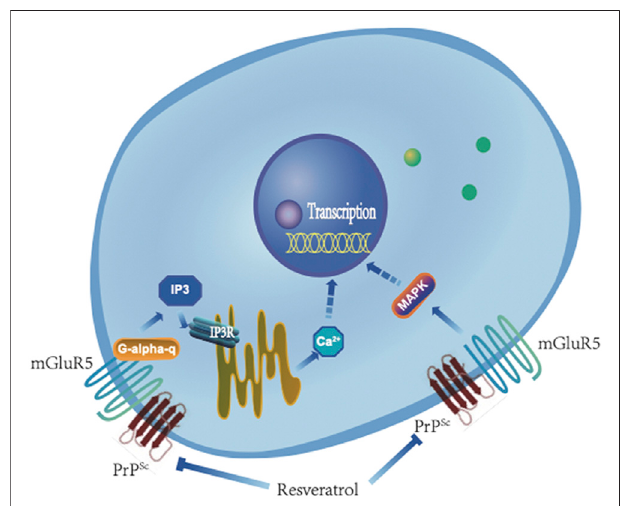
FIGURE 11 | A hypothetical processing schema of GPCR-IP3-IP3R- Ca 2+ andmGluR5-MAPKsignalingpathwaybeforeandafterremovalofPrP Sc by